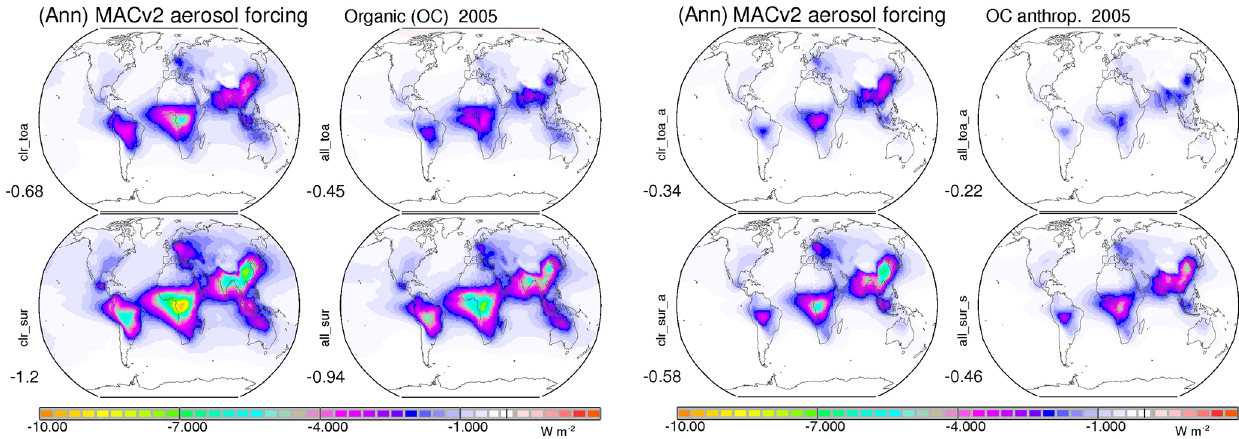
Figure E3. Annual average maps for present-day radiative effects of total (left frame) and anthropogenic (right frame) organic matter (OC). Each block displays impacts for clear-sky (left column) and all-sky conditions (right column) at both TOA (top row) and surface (bottom row). Blue to purple, green and yellow indicate an increasing cooling. Values below the labels are global